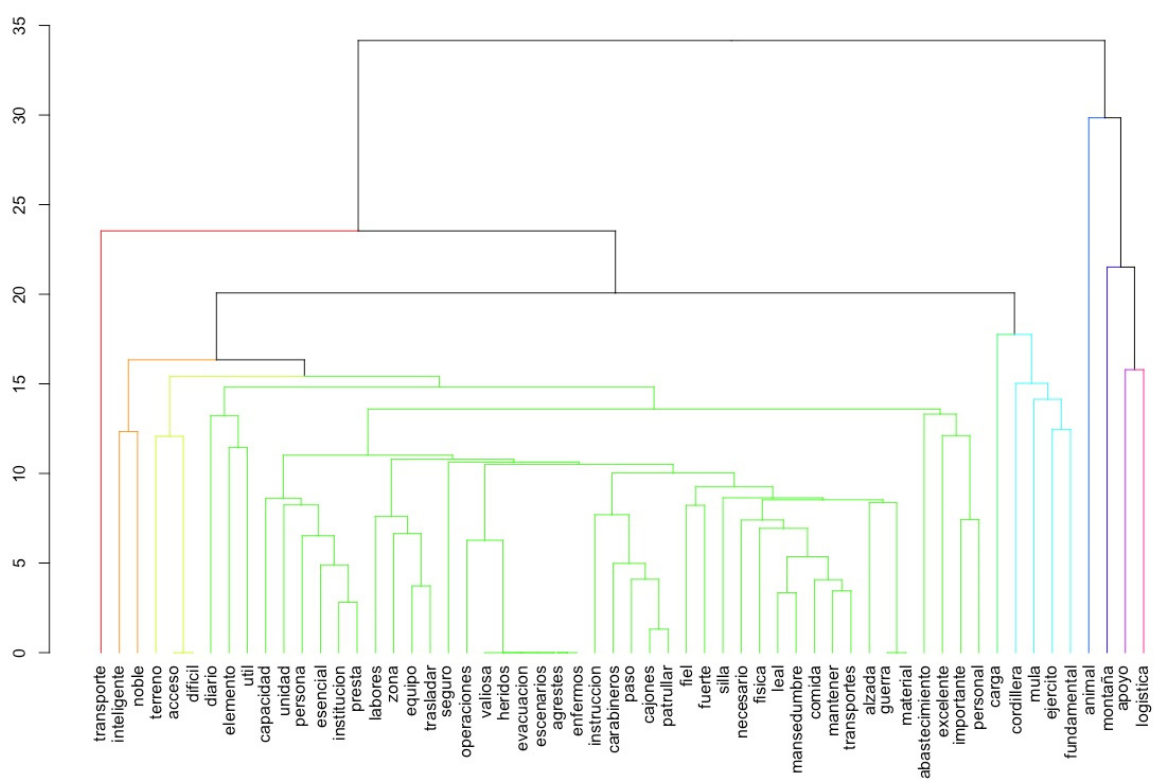
Figure 1. Dendrogram of words for the question, “What do mules represent or mean for you?” The y-axis represents the Euclidean distance (dissimilarity level), and the x-axis the word clusters. Words are in Spanish to not alter the dendrogram. Table 6. Description of the three clusters and the principal words that describe the cluster. Clusters Three Principal Words in the Cluster Cluster